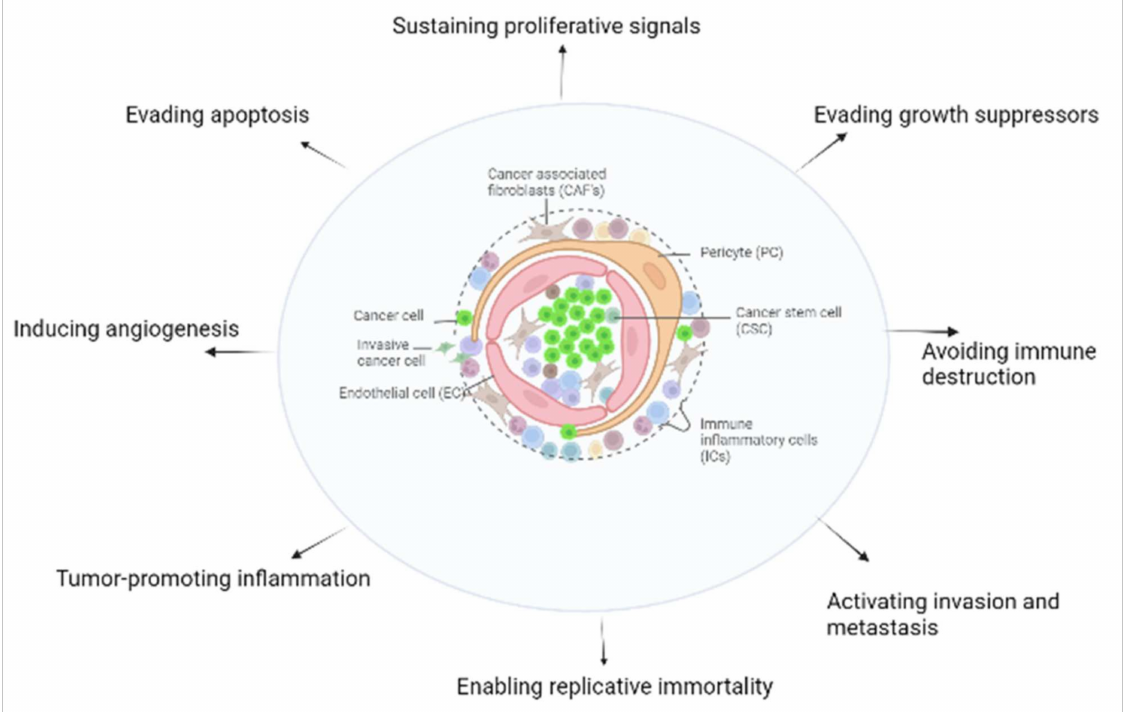
Figure 2. Roles of cancer stromal cells in the hallmarks of